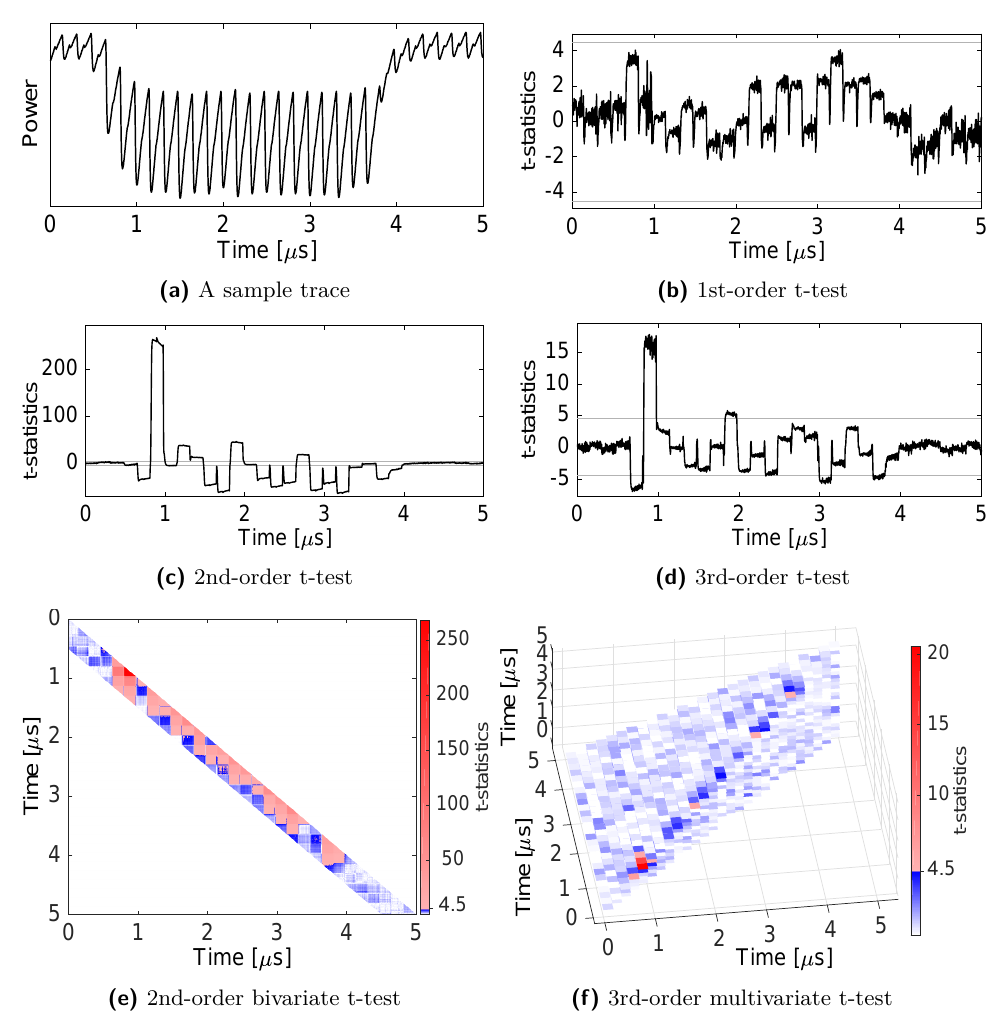
Figure 5: Experimental analysis of our two-share Keccak - f [200] design using 100 million